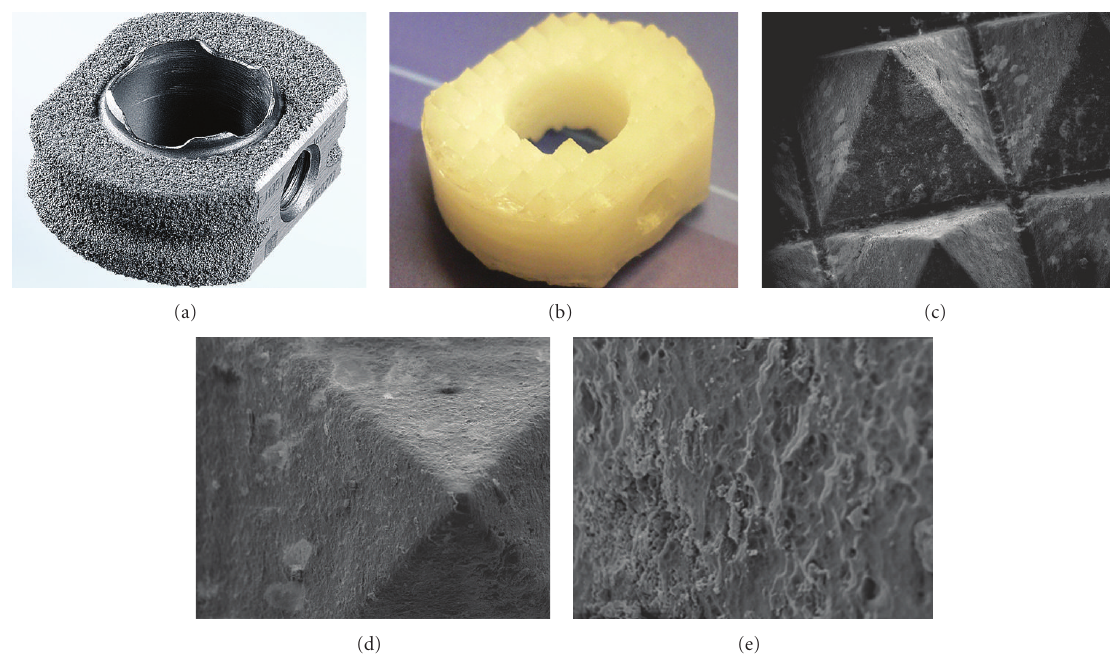
Figure 1: (a) CeSpace Titanium Plasmapore cage serving as a control implant for the in vivo study. (b) Poly-(70L/30DL)-lactide-fiber- reinforced β -tricalcium phosphate ( β -TCP) composite cage (PLA70/ β -TCP) for the in vivo study. (c), (d), and (e) Scanning electron micrograph (SEM) images of PLA70/ β -TCP composite matrix by magnifications of 35X, 100X, and 500X, respectively, showing the ceramic particles in the surface of the polymer matrix without any isolating